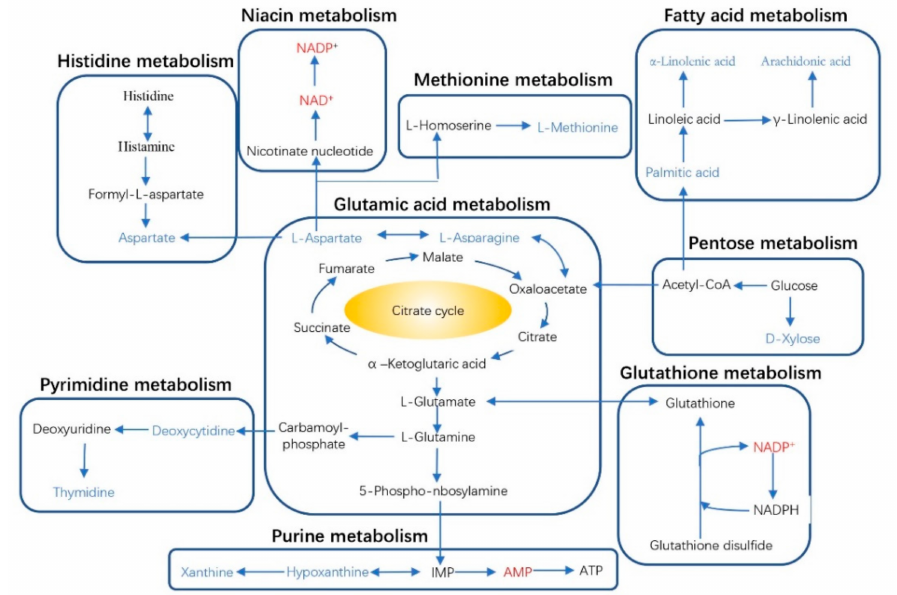
Figure 4. Schematic diagram of metabolic pathways with supplementary Astralagus membranaceus (AMT) (80 g/kg DMI, A 80 ) in Tibetan sheep. Compared with control (without supplementary AMT), biomarkers with red font indicate an increase in the abundance of the responding biomarkers, blue fonts indicate a decrease in the abundance of the responding biomarkers, and black fonts represent no